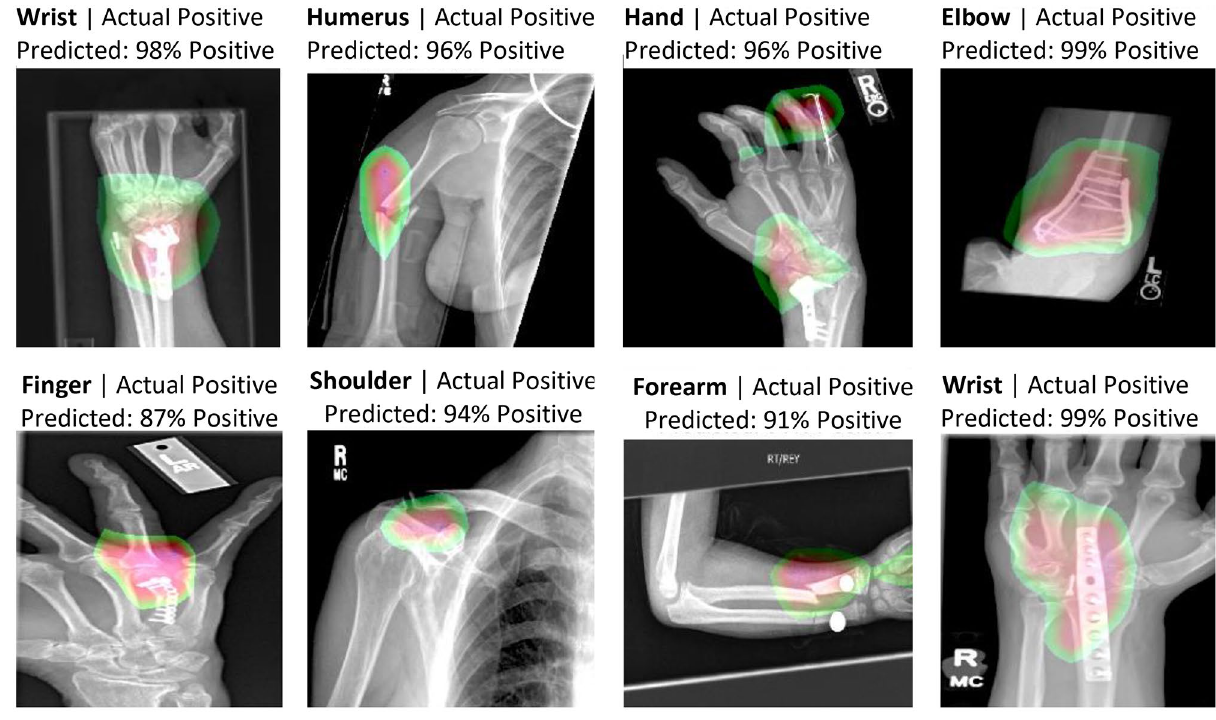
Figure 3. Sample class activation